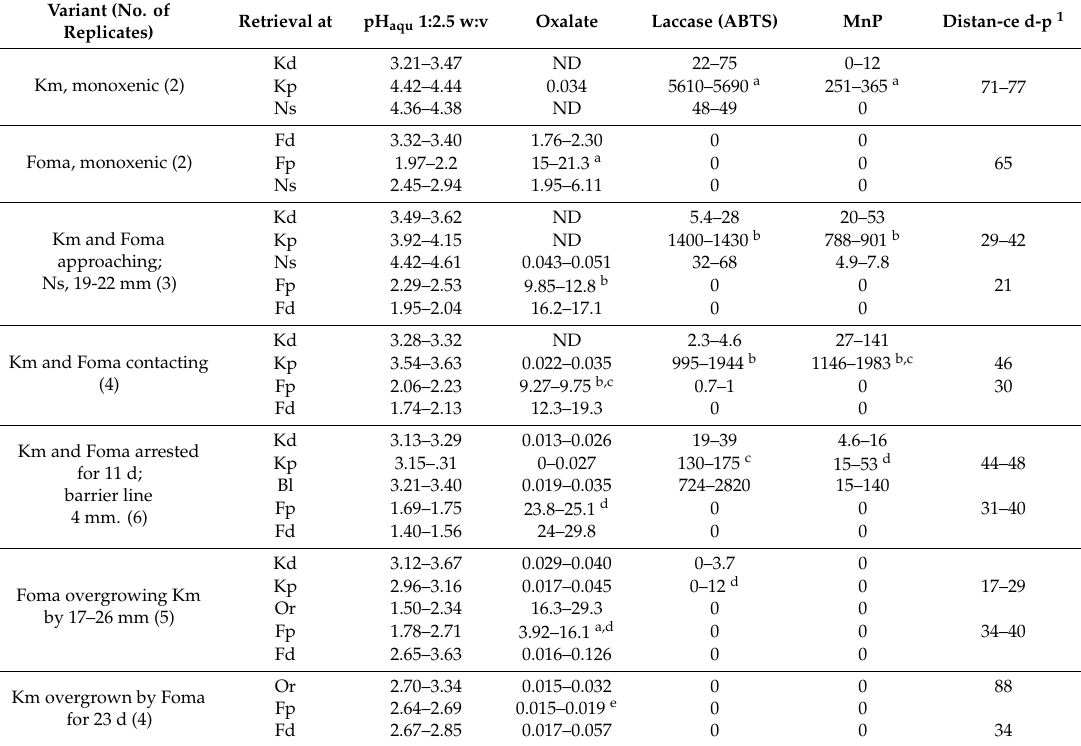
Table 1. Ranges of variation: production of soluble oxalate (g kg − 1 wood dry weight (DW)) and activities of laccase and MnP ( µ mol min − 1 kg − 1 wood DW) by monoxenic and interacting mycelia of Km 10 and Foma 4 growing in 100 mm long beech wood columns of glass tubes. Refer to Figure 1 for the location of substrate